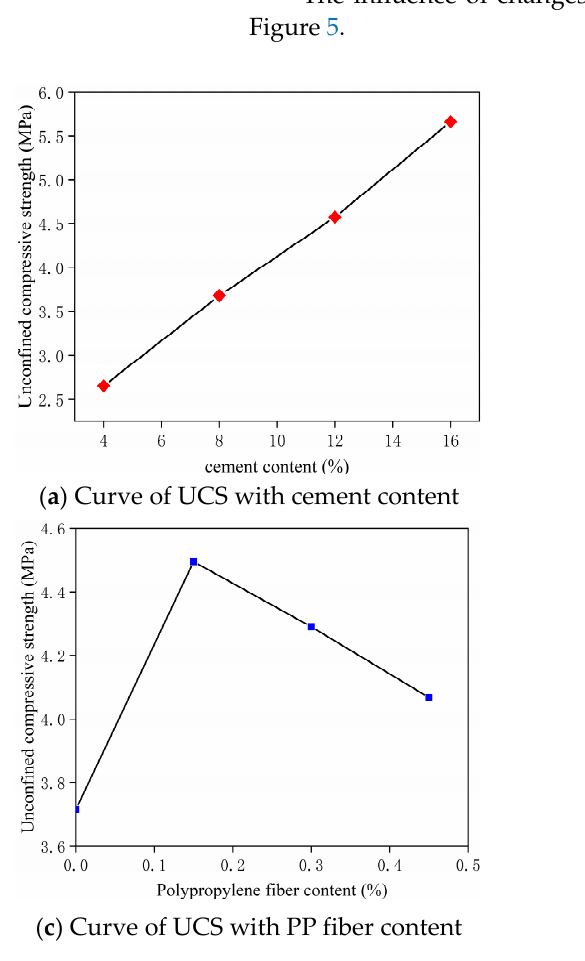
Figure 5. The impact of UCS with the level of various influencing factors.